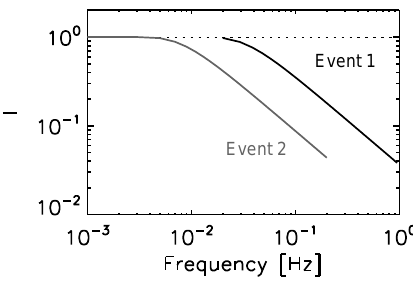
Figure 3. Measure of Taylor’s hypothesis accuracy I as a function of spacecraft-frame frequencies in the solar wind for event 1 (Narita et al., 2013) and event 2 (Narita,